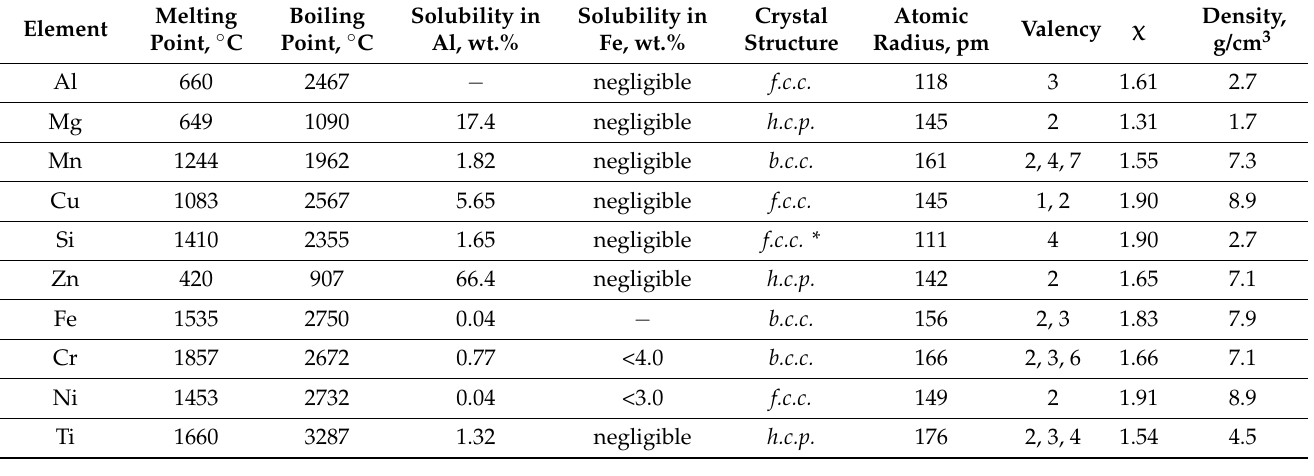
Table 1. Thermophysical properties of different metals [57–59]. Solubility values are maximum possible values usually achieved at high temperatures (e.g., >700 ◦ C). Face-centred cubic denoted as f.c.c. , body-centred cubic as b.c.c , and hexagonal close-packed as h.c.p. crystal structures. Note, Si has complex face-centred diamond cubic crystal structure (*). Indicated valency (+) values are most common. χ is electronegativity by Pauling scale.